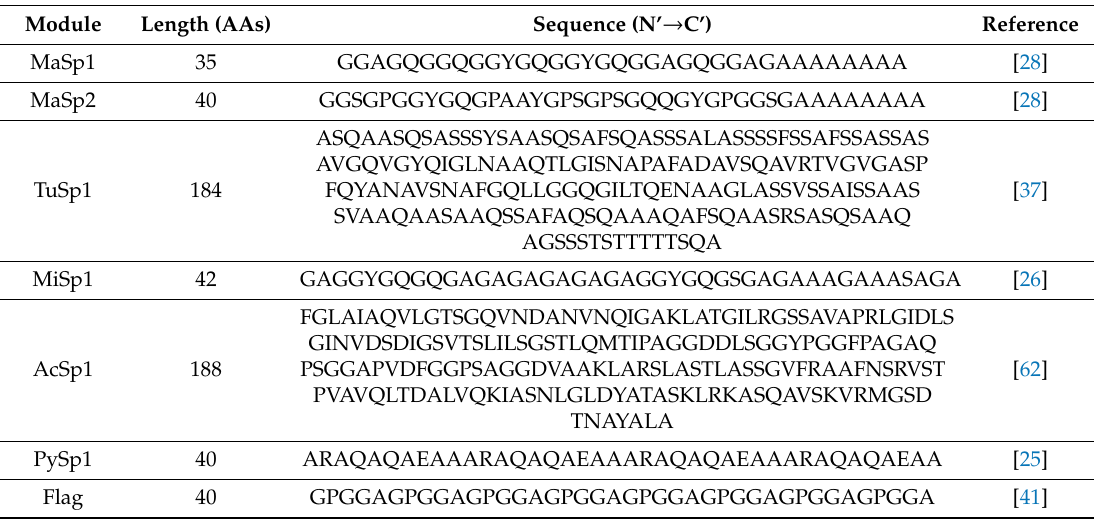
Table 1. Summary table of primary sequences of individual monomeric protein constructs used in Library.